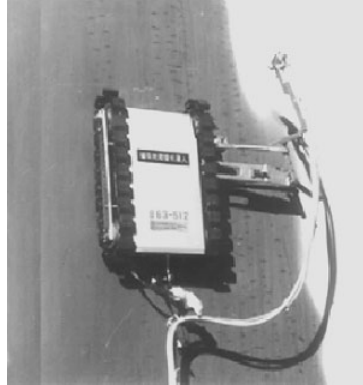
Figure 22 Wall-climbing robot for oil tank